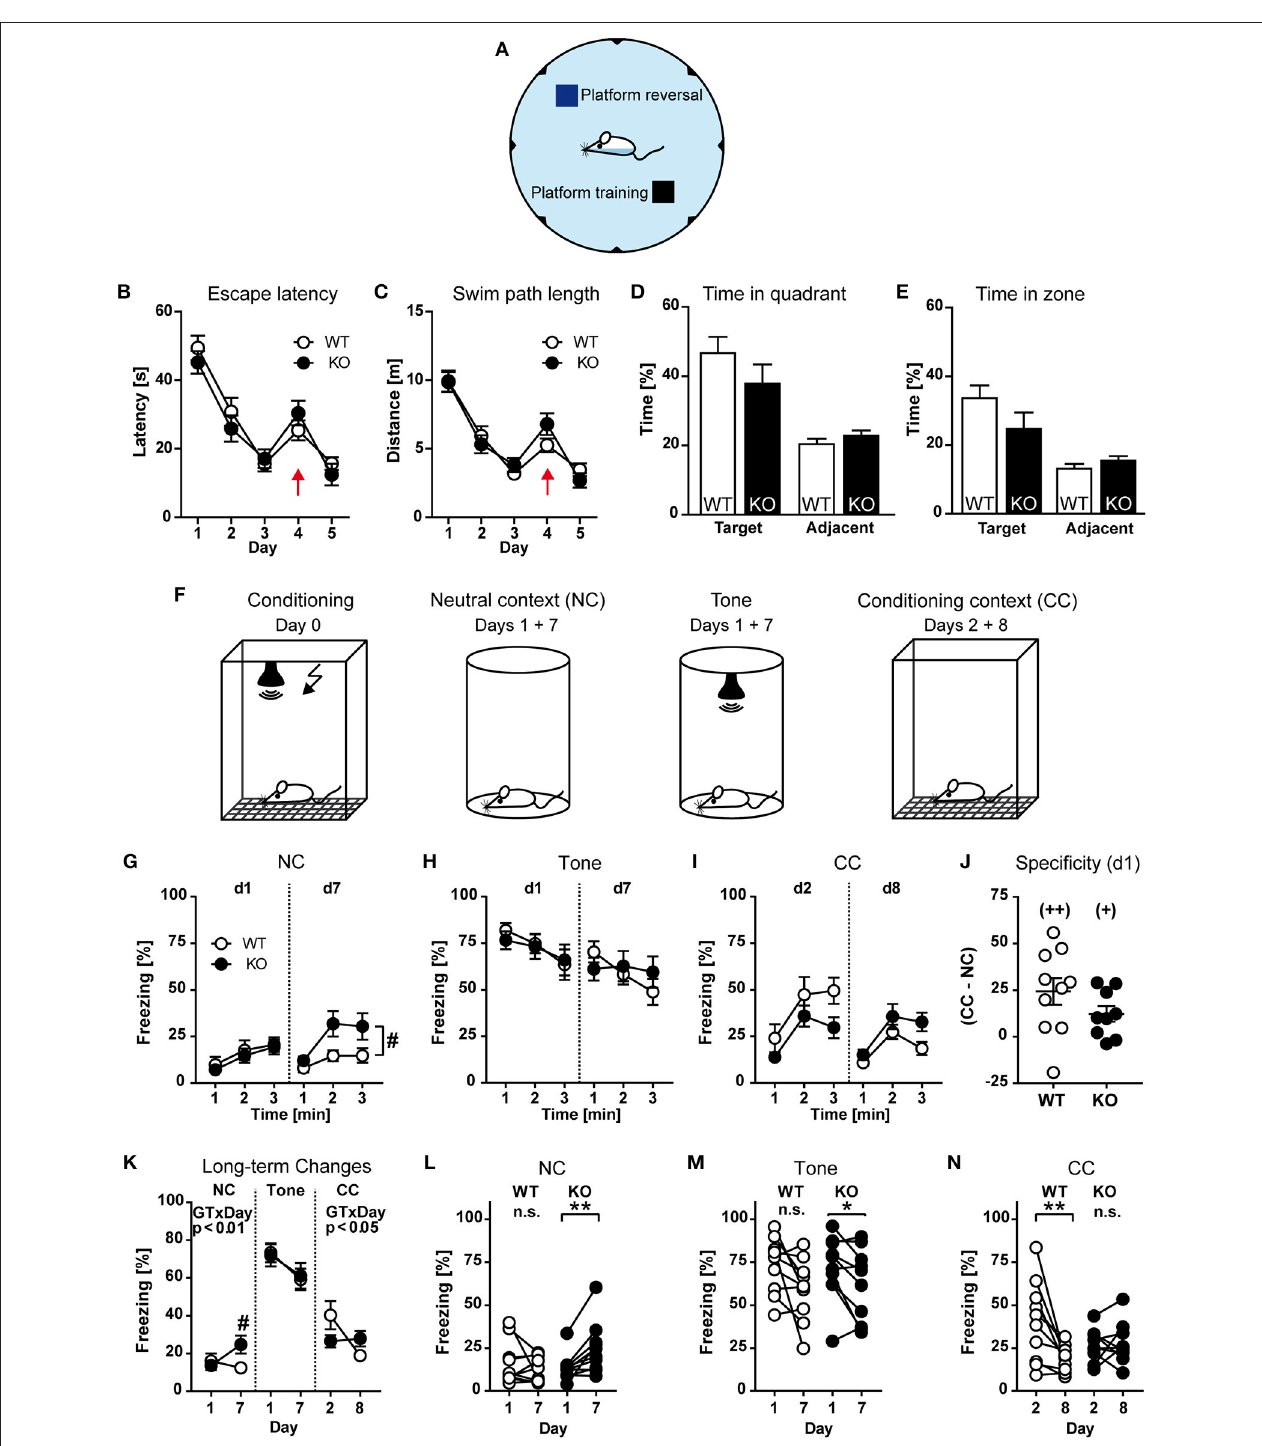
FIGURE 7 | Behavioral characterization of HCN3 − / − mice (part 3). (A–E) Morris water maze. During training (days 1-3) the platform was hidden in a specific quadrant of the maze and its position was changed on the first trial of day 4 (probe trial) to a different quadrant and remained there until the end of the experiment (A) . According to escape latencies (B) and swim path length (C) , mice showed robust learning (days 1–3), reversal effect (day 4; indicated by red arrow), and re-learning (day 5) with no evidence for a genotype effect. During the probe trial (first trial on day 4) the mice showed a robust preference for the trained quadrant compared to the average of the two adjacent quadrants (D) and for a circular zone (12.5% of pool surface) drawn around the former platform location (E) . (F–N) Fear conditioning. For